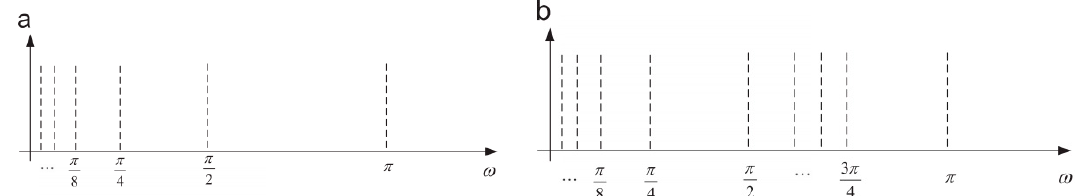
Figure 2. The advantages of WPT: ( a ) Dyadic WT time-frequency plane tiling; ( b ) Dyadic WPT time-frequency plane tiling.